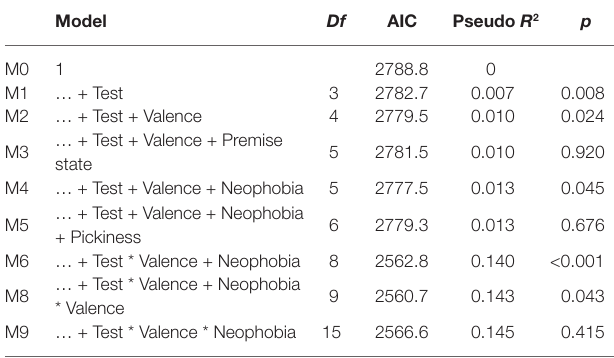
TABLE 3 | The goodness of fit of the generalized linear mixed models. Model